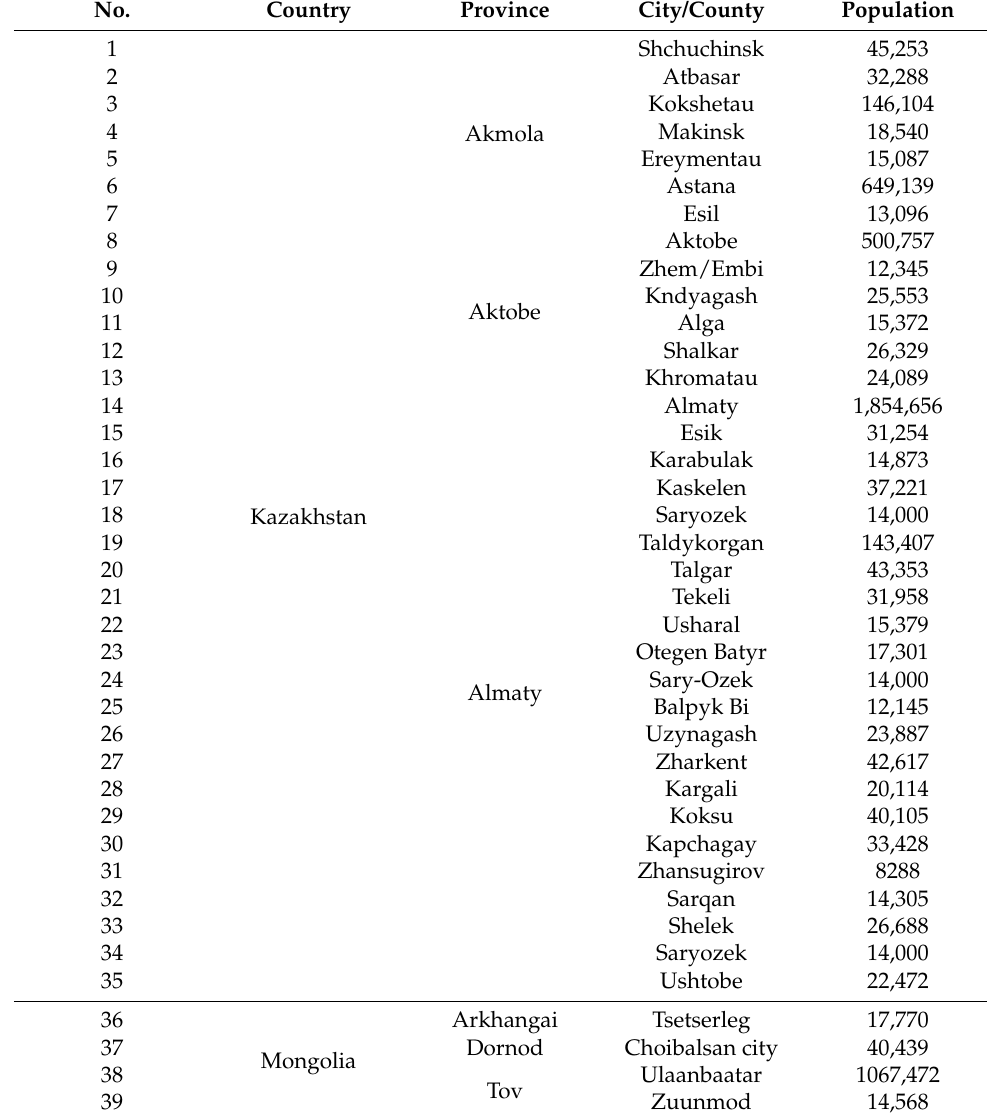
Table A1. Counties with their urban areas removed from our